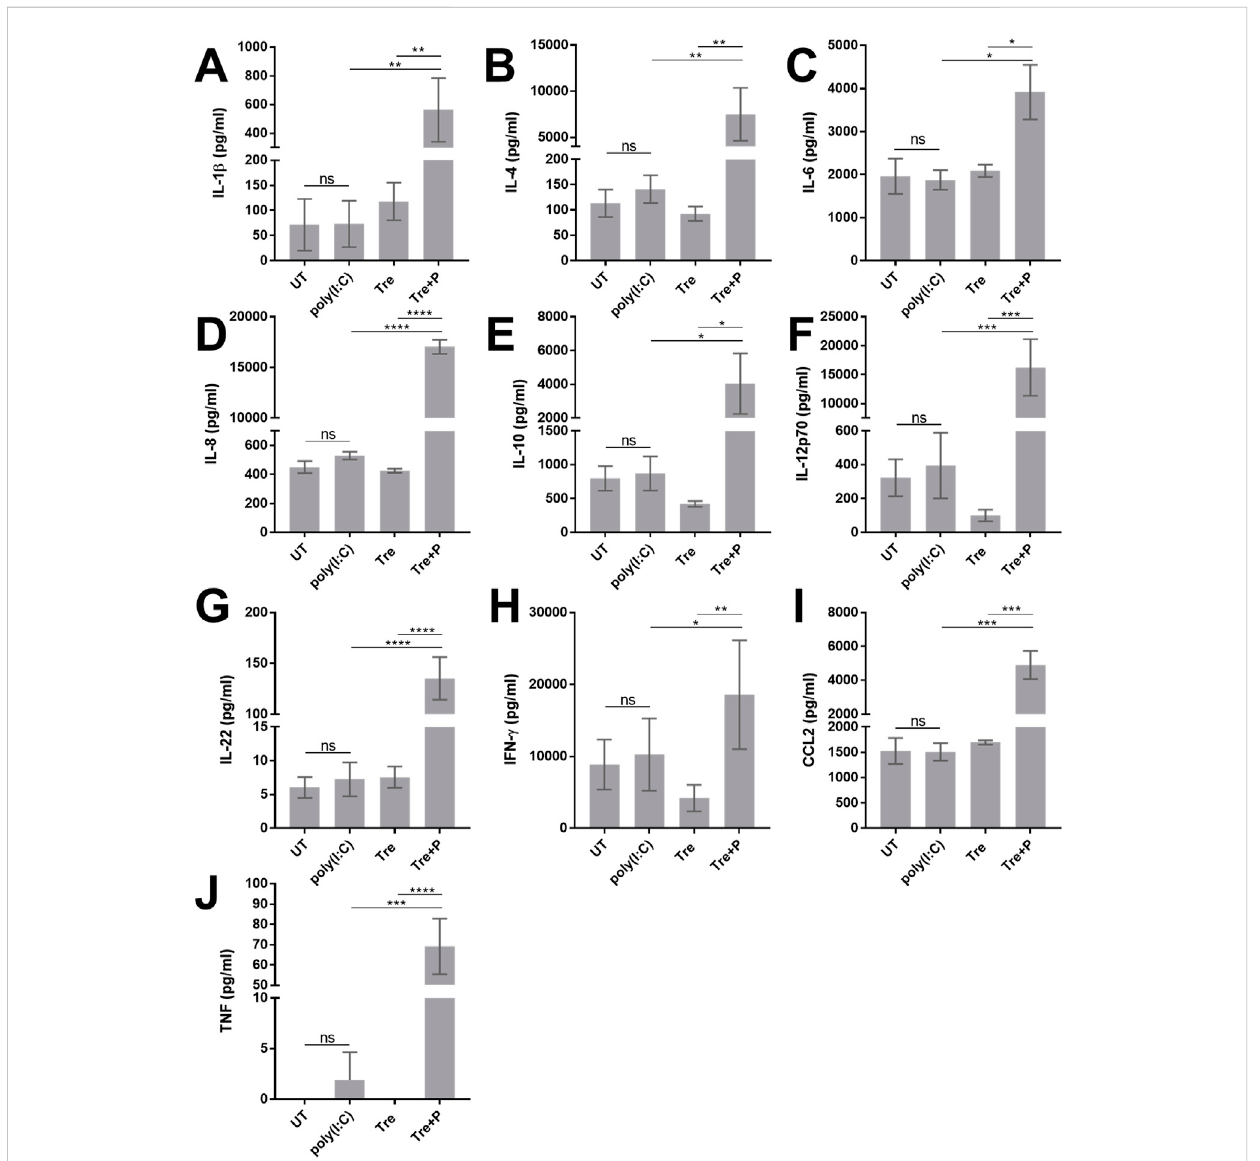
FIGURE 11 Trehalosepotentiatespoly(I:C)-mediatedreleaseofvariouscytokines.HMC3wereleftuntreated(UT)ortreatedwith0.15mMtrehalose(Tre)for3h andsubsequentlystimulatedwith0.5 μ g/mLpoly(I:C)for24h(Tre+P).Forcomparison/controls,HMC3weretreatedwith0.5 μ g/mLpoly(I:C)for24hor 0.15mMtrehalose(Tre)for24h.Cellfreesupernatantswerecollectedandanalyzed via electrochemiluminescentmultiplexanalysisfor (A) IL-1 β , (B)